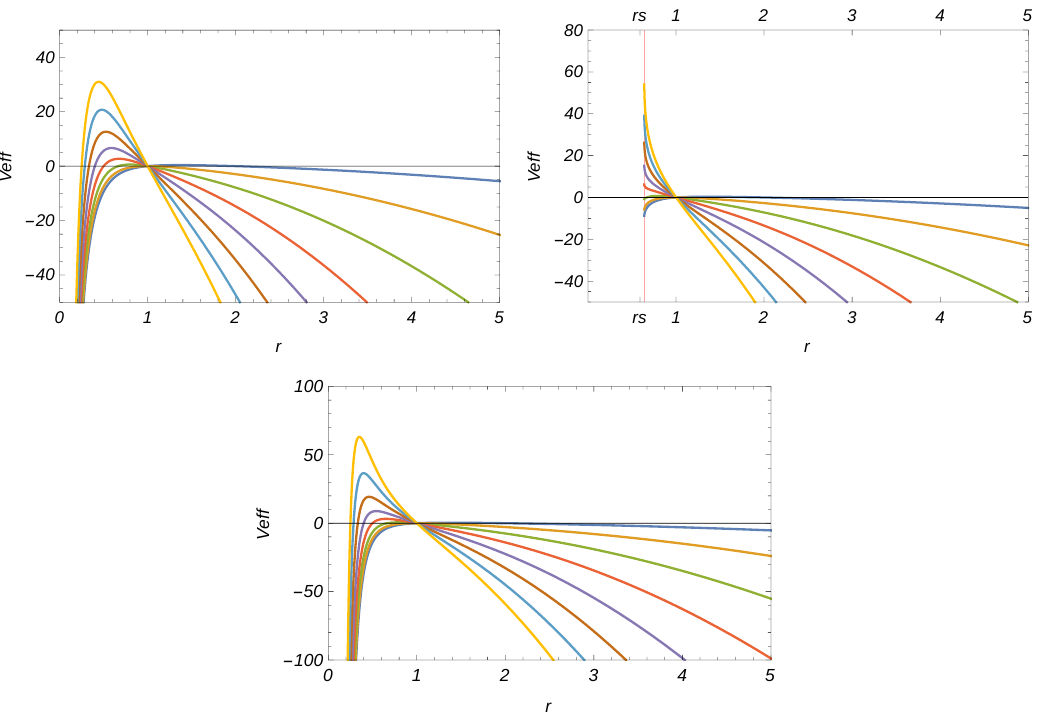
Figure 2 . E(cid:11)ective potential V e(cid:11) ( r ) for m = 1 and di(cid:11)erent values of J . Left panel: (cid:21) GB = : 05. Right panel: (cid:21) GB = (cid:0) 0 : 05 : In the lower panel we have included the SAdS case for